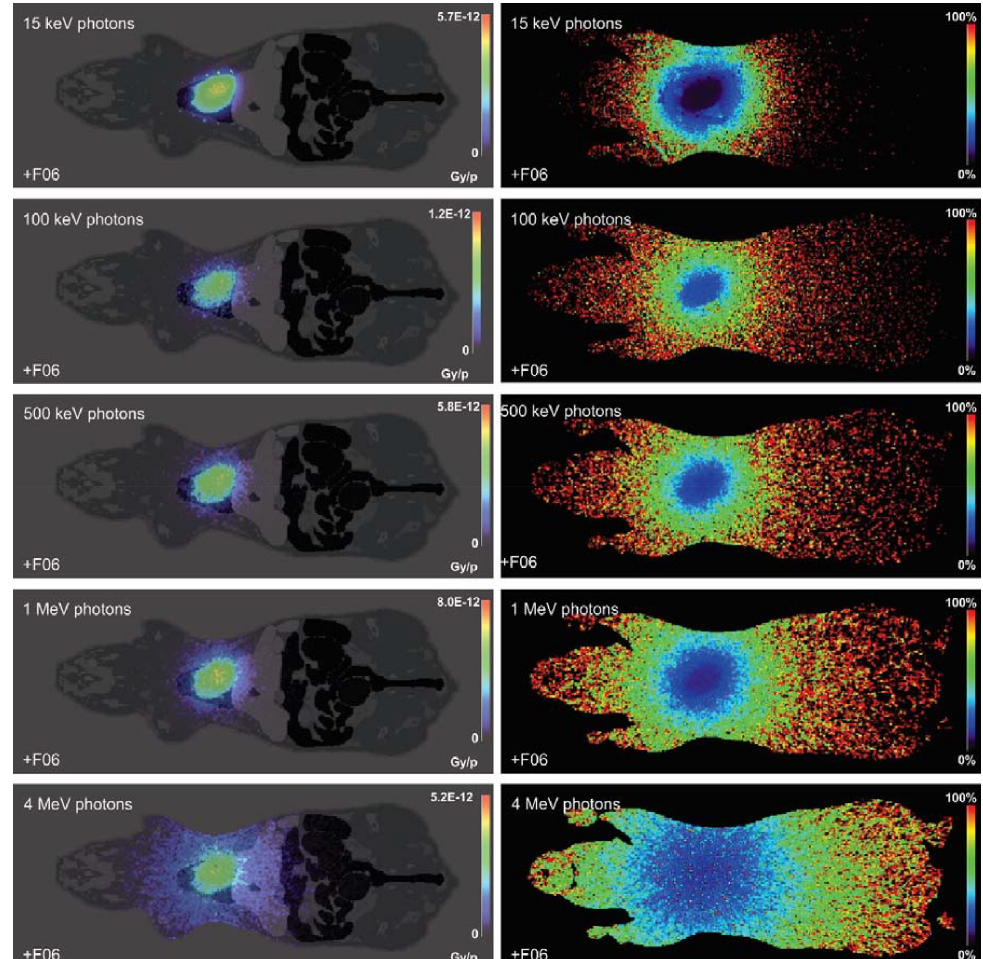
FIGURE 3 - Coronal slices from Amide ® software presenting the absorbed doses (left side) and relative errors (right side) distribution pattern for 15 keV, 100 keV, 500 keV, 1 MeV or 4 MeV photon emitted at heart. The values were evaluated with +F6 tally. NPS was set to